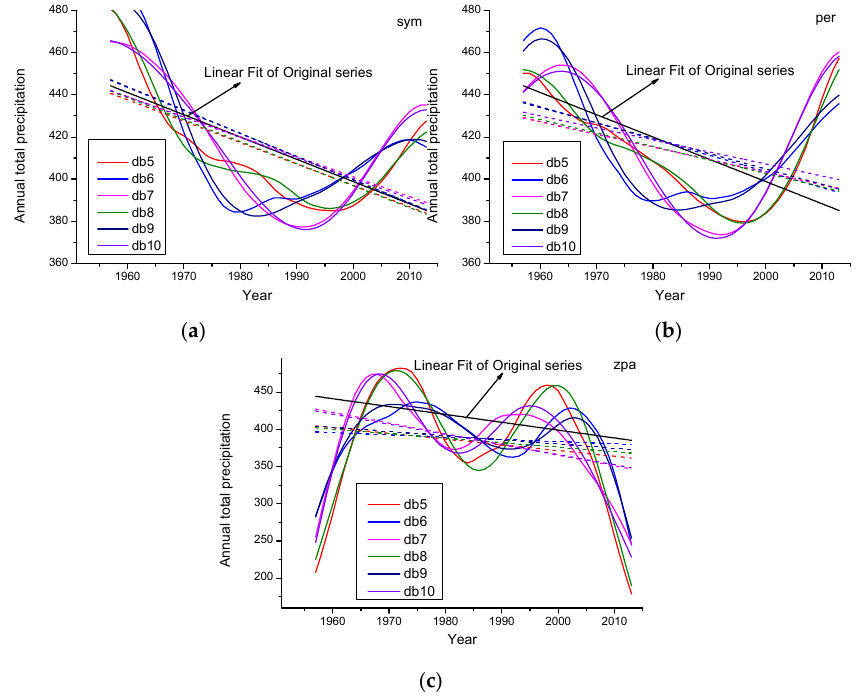
Figure 5. Linear fit of original series and approximate components of annual total precipitation series in three extension modes (sym: symmetrization extension; per: periodic extension; zpa: zero-padding extension) with the decomposition level L = 4. The dash lines are the linear fits of the approximate components decomposing from different db types. ( a ) sym; ( b ) per; ( c ) zpa. Table 3. The results of extension mode, decomposition levels and db type that were used in DWT of monthly, seasonal and annual flow and precipitation series in the three criteria (MS: monthly streamflow; SS: seasonal streamflow; AS: annual streamflow; MP: monthly precipitation; SP: seasonal precipitation; AP: annual precipitation; sym: symmetrization extension; per: periodic extension; zpa: zero-padding